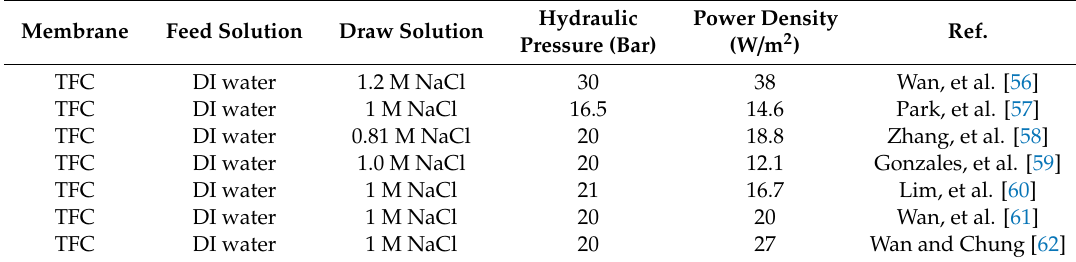
Table 3. PRO performance of recent hollow fiber membranes.